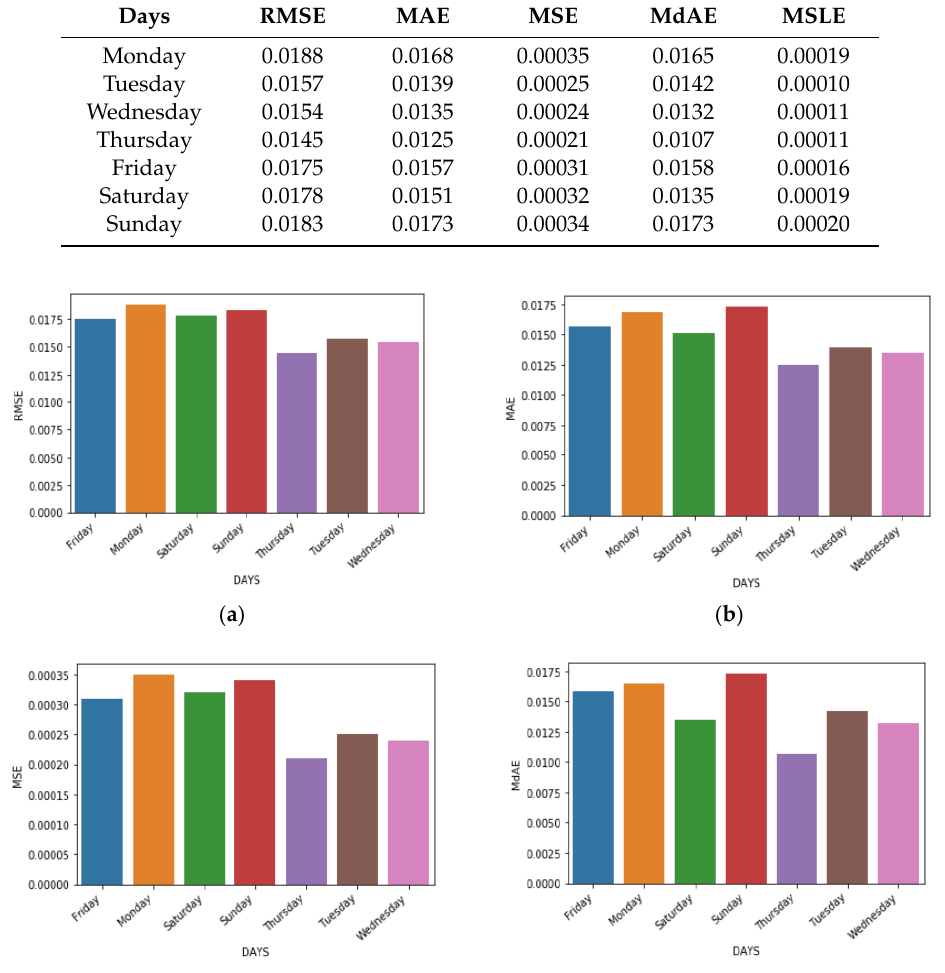
Table 4. Day-Wise Results of LSTM recurrent neural network (RNN).